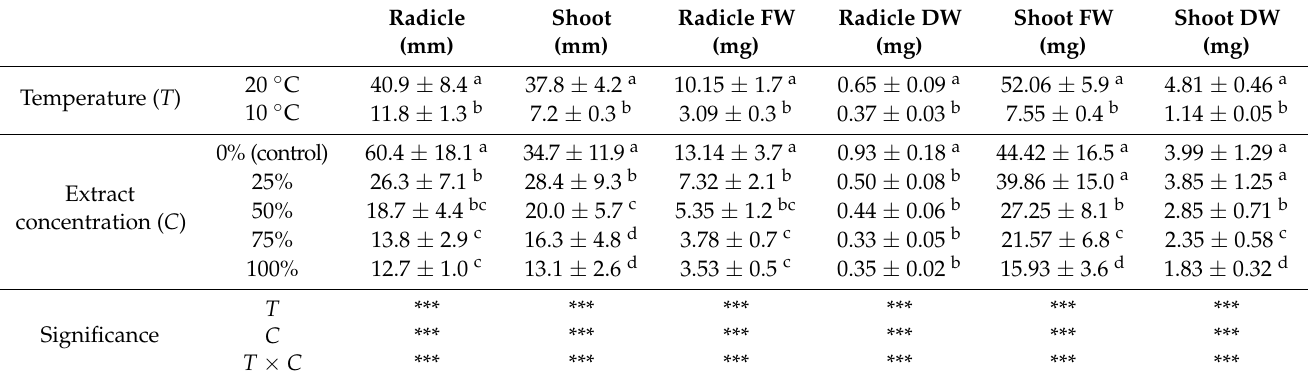
Table 6. Main effects of temperature and hemp leaf extract concentrations on radicle and shoot length, fresh (FW) and dry weight (DW), in wheat cv. Mongibello. Radicle